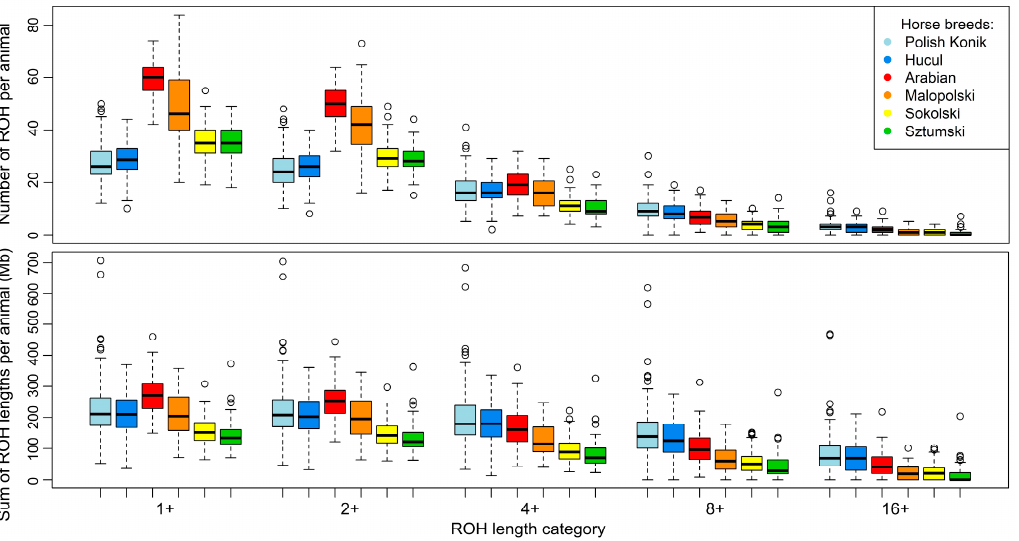
Figure 2. Box plot representing basic statistics of runs of homozygosity length and number in selected horse breeds.